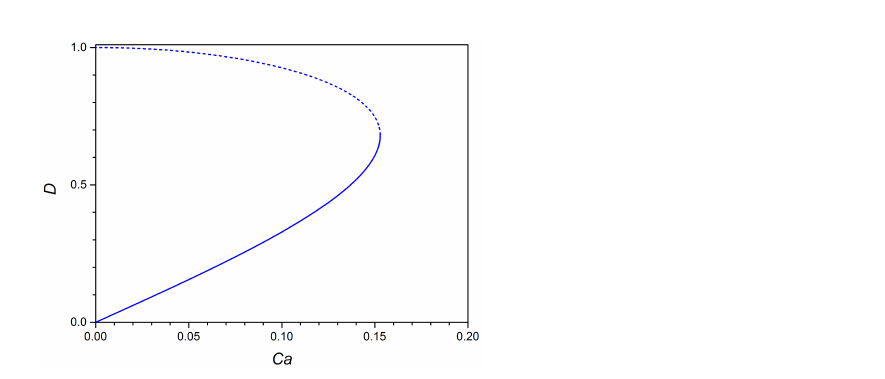
Figure 5. Numerical solution of Equation (4). The lower branch (solid line) corresponds to the physical solution, while the upper branch (dashed line) is unphysical.